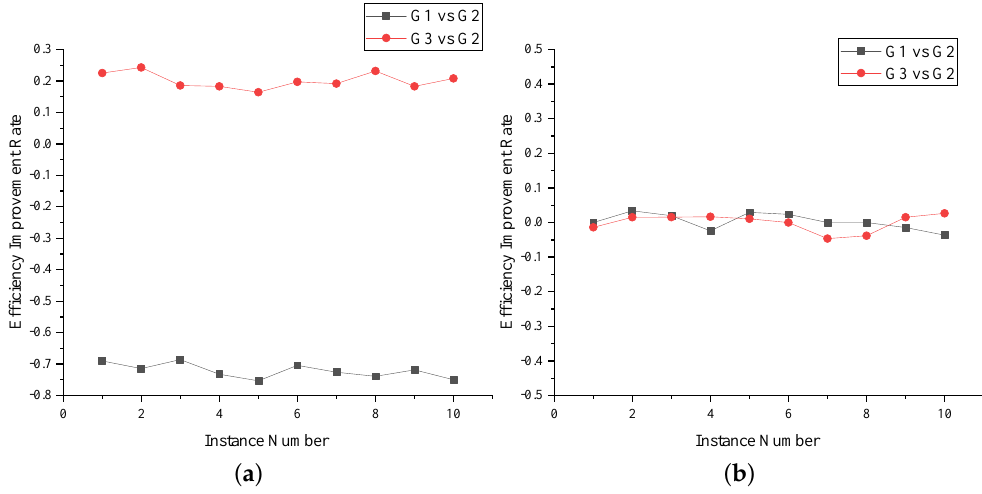
Figure 5. Comparative experimental results obtained with different test sequence selection criteria. ( a ) LightFTP. ( b )